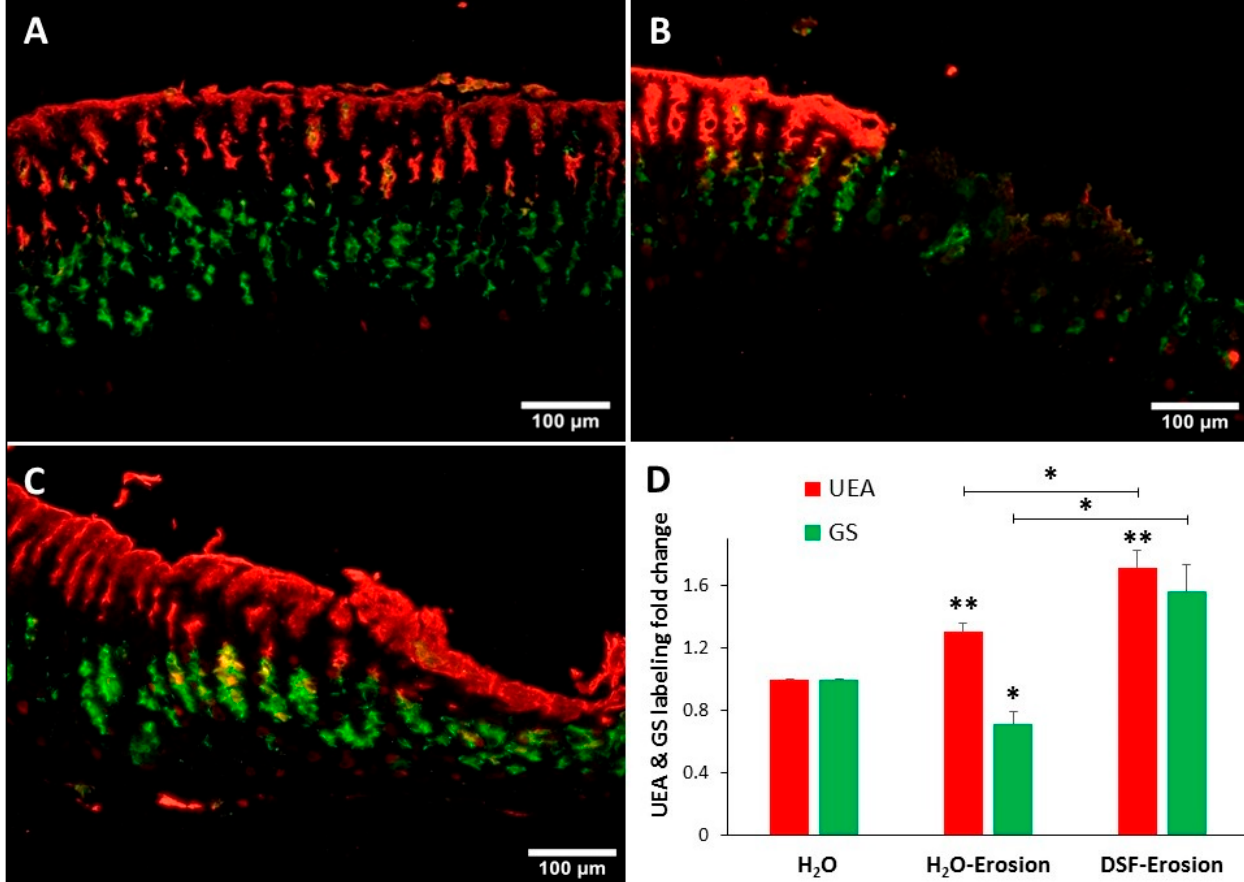
Figure 6. Double lectin histochemistry of the gastric mucosa of H 2 O control ( A ), erosion-induced ( B ) and DSF-erosion ( C ) mice. Stomach tissue sections were incubated with rhodamine-conjugated UEA-I lectin (red) and GSII-FITC (Green). UEA-I demarcates the surface mucous cells lining the luminal surface and the mucosal pits. GSII lectin defines the mucous neck cells in the middle of the mucosa. ( D ) Fold change in the levels of UEA-I and GSII labeling intensity of control ( n = 3), gastric lesion ( n = 3) and DSF-erosion ( n = 3) tissues ( D ) are presented as mean ± SE. * p < 0.05, ** p < 0.01; scale bar = 100 µm.